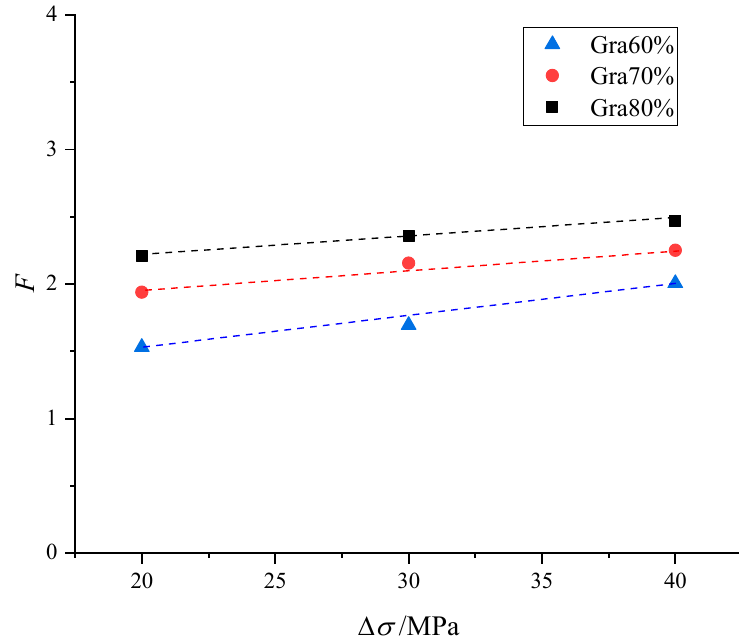
Figure 16. Evolution of the fractal dimension F. Table 6. Statistical results: parameters of fragments of the granite.